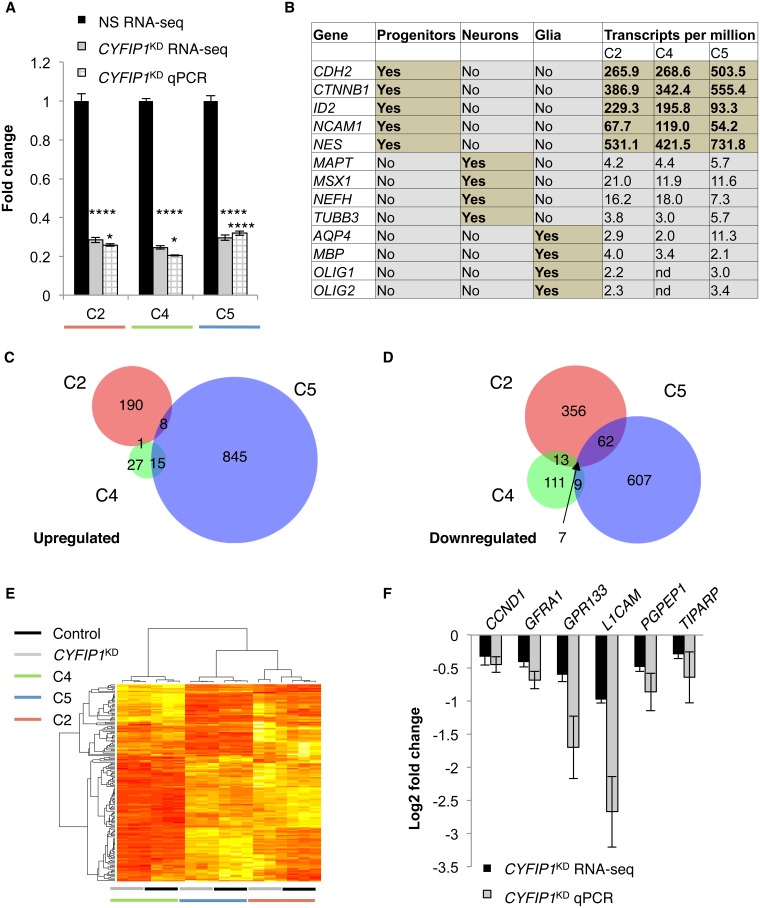
CYFIP1 knockdown results in dysregulation of hundreds of genes in human neural progenitor cells (NPCs). (A) RNA-seq and qPCR show that compared to non-silencing control transduced NPC lines (NS, black), cells transduced with an shRNA targeting CYFIP1 (CYFIP1KD, grey and hatched) show a significant reduction in CYFIP1 mRNA in lines from three different BP1-2 copy number neutral individuals (C2, red; C4, green; C5, blue, n = 3 per group throughout). P-values for RNA-seq analysis- DESeq2; qPCR- one-tailed Student’s t-test; *p≤ 0.05; ****p≤0.0001. (B) RNA-seq shows that mRNAs for NPC markers are expressed 10 to 100-fold higher than mRNAs for neuronal and glial markers. TPM values are averaged across NS and CYFIP1KD samples. (C, D) Only a handful of genes are similarly dysregulated in response to CYFIP1 knockdown across all three NPC lines evaluated. (E) Unsupervised hierarchical clustering of genes showing nominal differential expression (p<0.05) points to marked between-line differences. (F) RNA-seq and qPCR on mRNA from control and CYFIP1KD NPCs (CYFIP1KD RNA-seq, black; CYFIP1KD qPCR, grey) show reduced levels of genes downregulated in all three cell lines. Abbreviations: CCND1- cyclin D1, GFRA1- GDNF family receptor alpha-1, GPR133- G-protein coupled receptor 133, L1CAM- L1 cell adhesion molecule, PGPEP1- pyroglutamyl-peptidase I, TIPARP- TCDD-inducible poly(ADP-ribose) polymerase.